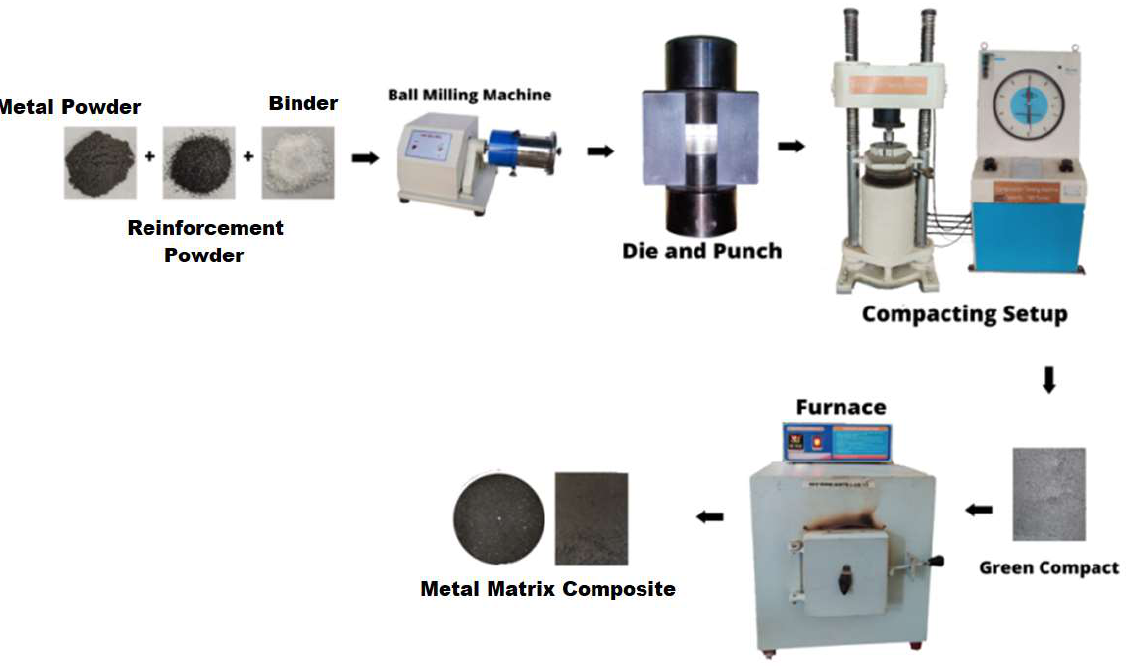
Figure 3. Powder metallurgy process.